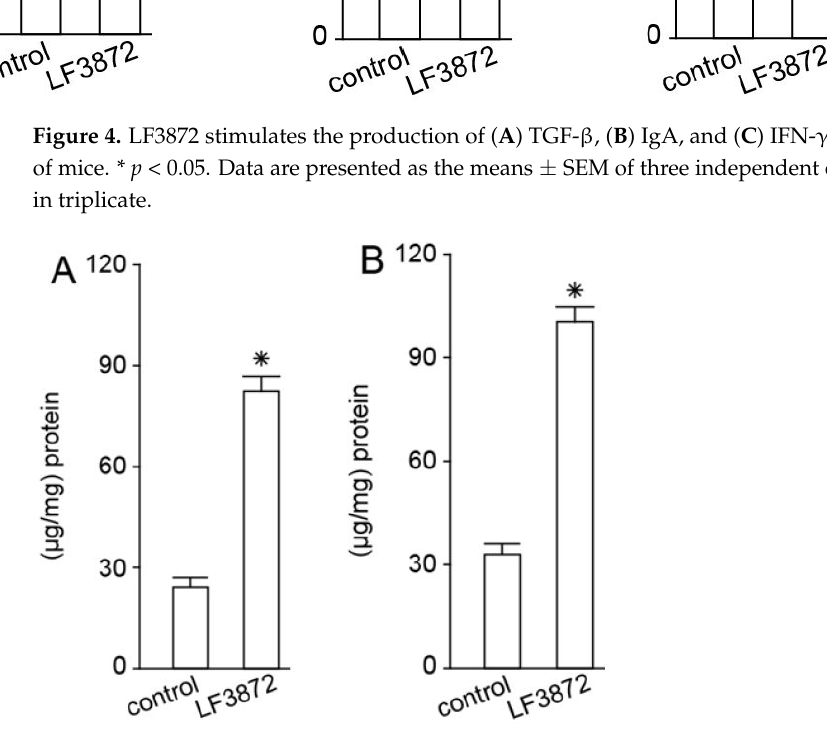
Figure 5. LF3872 stimulates the production of IgA in the small intestine ( A ) and colon ( B ) of mice. * p < 0.05. Data are presented as the means ± SEM of three independent experiments, tested in